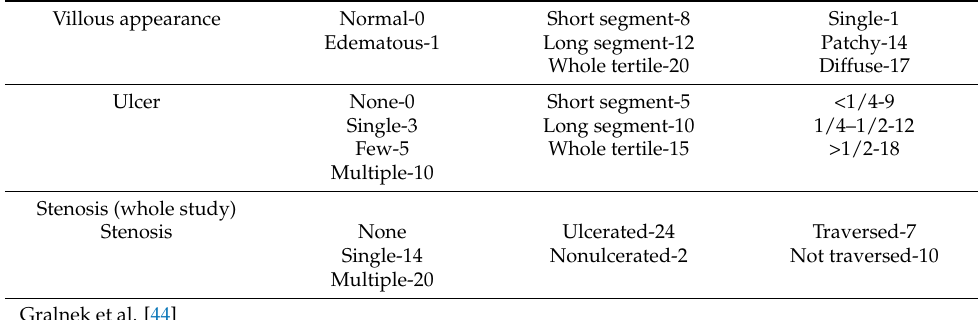
Table 2. The Lewis inflammatory score—embedded within PillCam software.